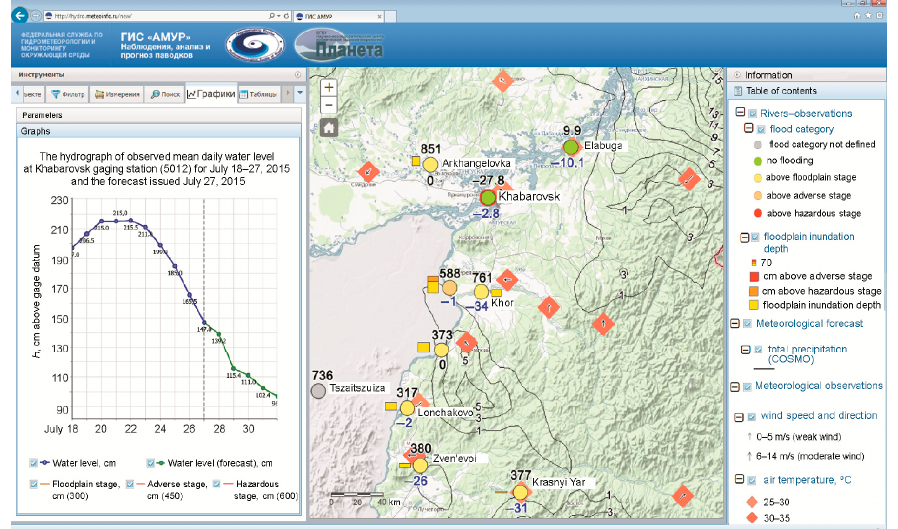
Figure 4. Presentation of hydrometeorological information in the flood forecasting and warning system web application: the observed (blue solid line) and forecast (green solid line) water levels at Khabarovsk (on the left); the observed and forecast hydrometeorological data (on the right).